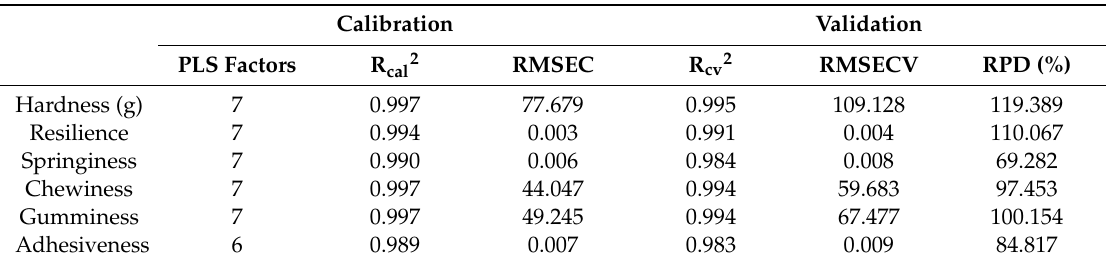
Table 4. Results of partial least squares (PLS) regression models for predicting texture parameters using the entire Carr–Purcell–Meiboom–Gill (CPMG) relaxation data of Spanish mackerel subjected to di ff erent cooking methods.